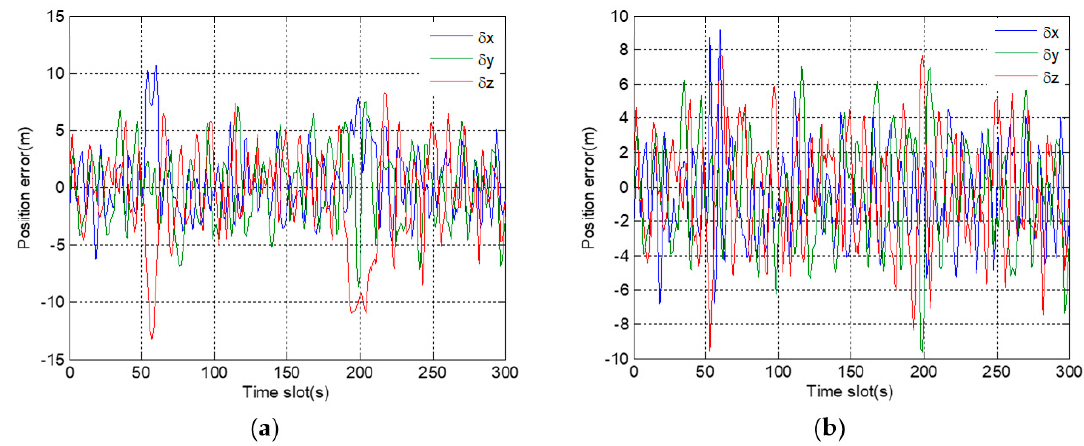
Figure 14. Position errors in 3D direction during occlusion: ( a ) before using a robust algorithm; ( b ) after using a robust